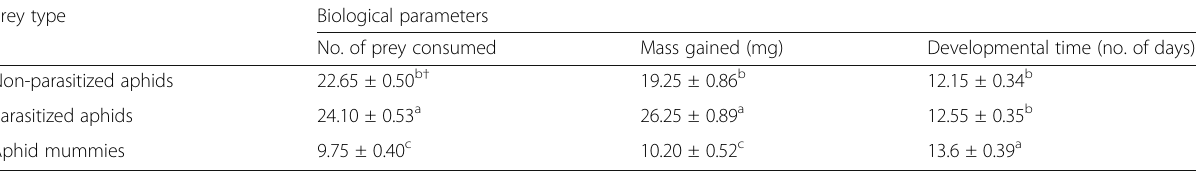
Table 1 Effect of feeding on parasitized, non-parasitized, and mummified aphids on the C. septempunctata biological parameters (mean ± S.E)